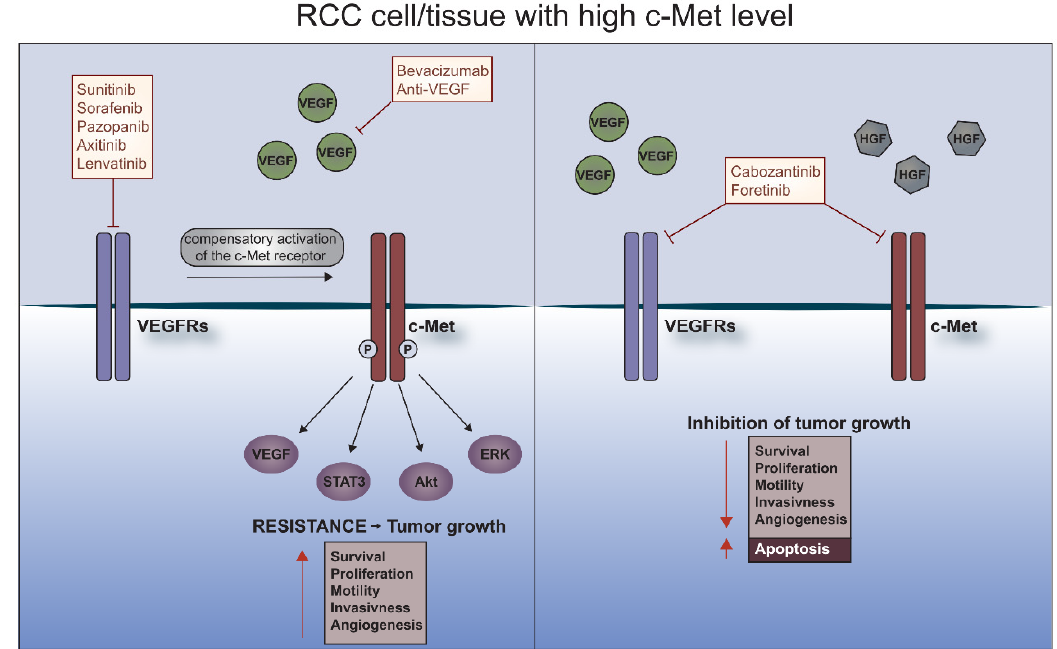
Figure 1. C-Met receptor and resistance to anti-cancer therapies in RCC. RCC tissue is characterized by a high level of c-Met receptor. Under treatment with VEGFRs inhibitors such as sunitinib, sorafenib, pazopanib, axitinib or lenvatinib, c-Met is phosphorylated and activates many downstream